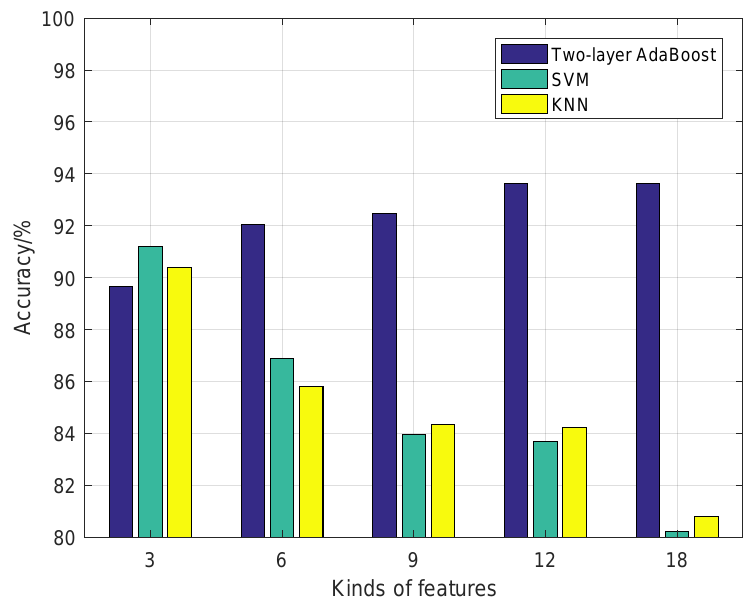
Figure 16. Comparison of different standard algorithms.